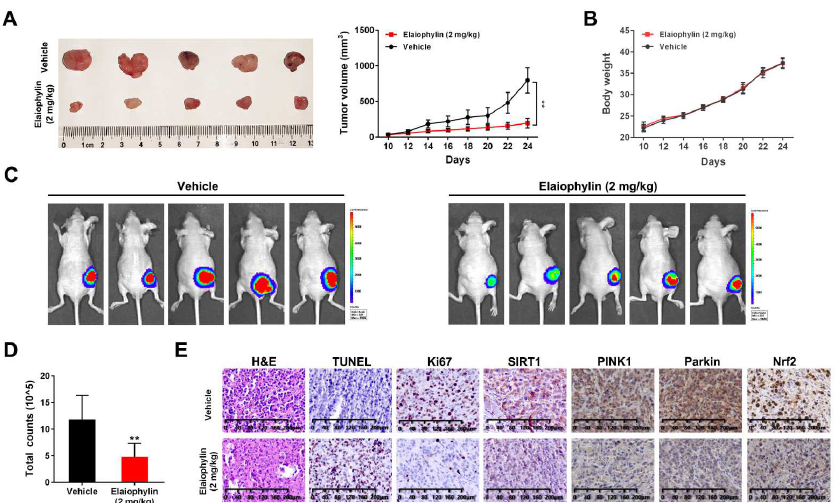
indicator Ki67 (brown color). Importantly, elaiophylin significantly decreased the level of SIRT1 in in vivo models, which is consistent with our in vitro findings (Figure 8E).